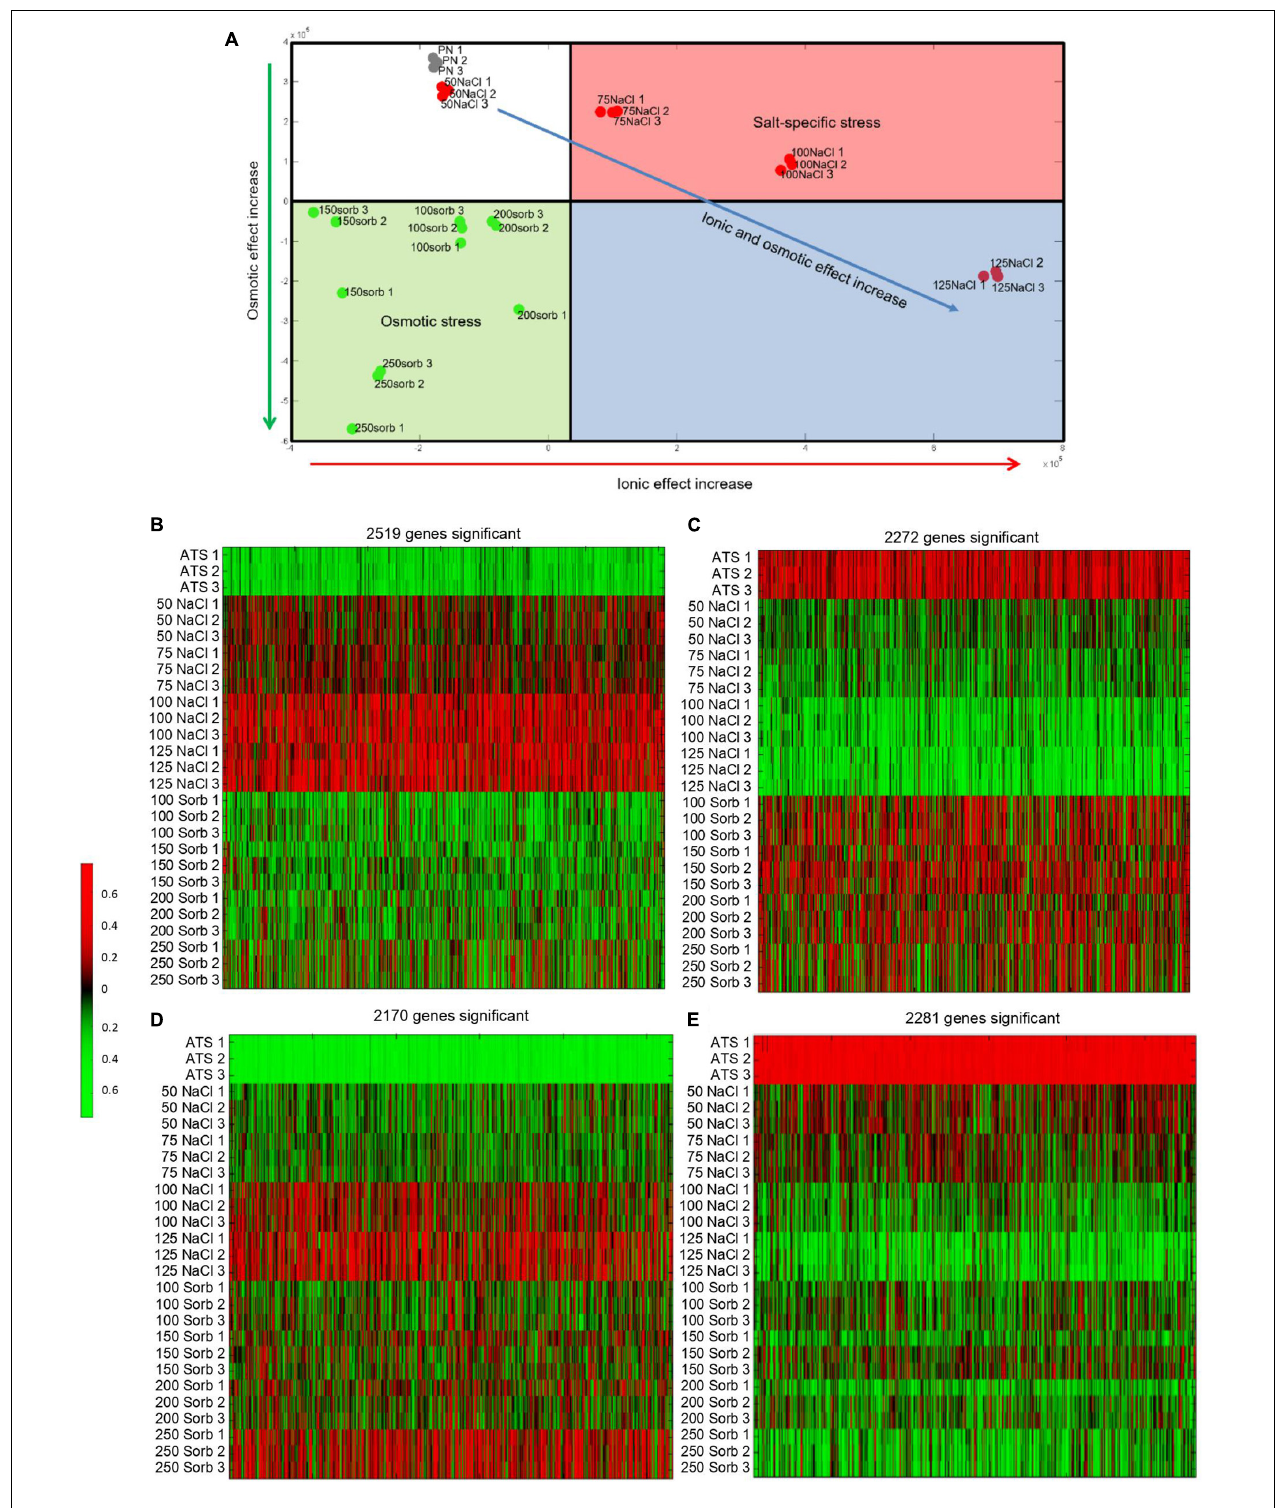
FIGURE 2 | Dimensional reduction plot and heat maps illustrating the genes differentially expressed in plants grown on NaCl and sorbitol. Microarray analysis was performed on plants grown in NaCl or iso-osmolar concentrations of sorbitol for two weeks from germination. The dimensional reduction plot ( A ) was generated from the normalized data to show how the data separated along two principal components corresponding to the ionic effect and osmotic effect of the treatments. The heat maps ( B-E ) were generated from lists of genes that were differentially expressed in plants grown on NaCl but not sorbitol compared to the untreated control